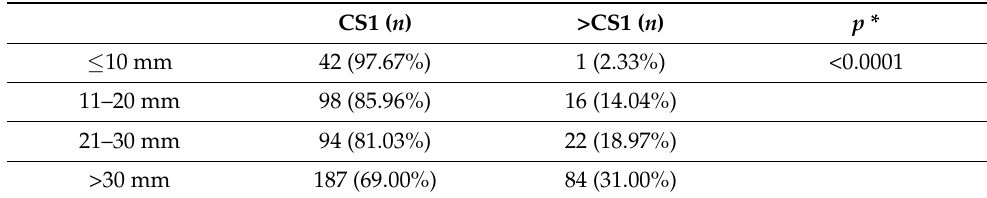
Table 8. Frequencies of localized disease (CS1) and metastasized cases (>CS1) of germ cell tumours (SE, NS) in four categories of increasing tumour size.